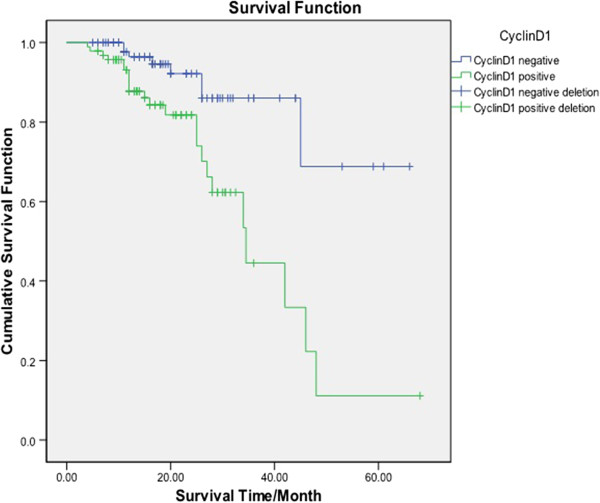
Kaplan-Meier survival curve of the expression CyclinD1 in 201 patients with endometrial diseases. Kaplan-Meier analysis of patients with and without CyclinD1 expression. The blue line represents the patients with CyclinD1 negative expression; the green line represents the patients with CyclinD1 positive expression. It clearly showed the patients with negative expression of CyclinD1 had higher overall survival rates than those with positive expression of CyclinD1.